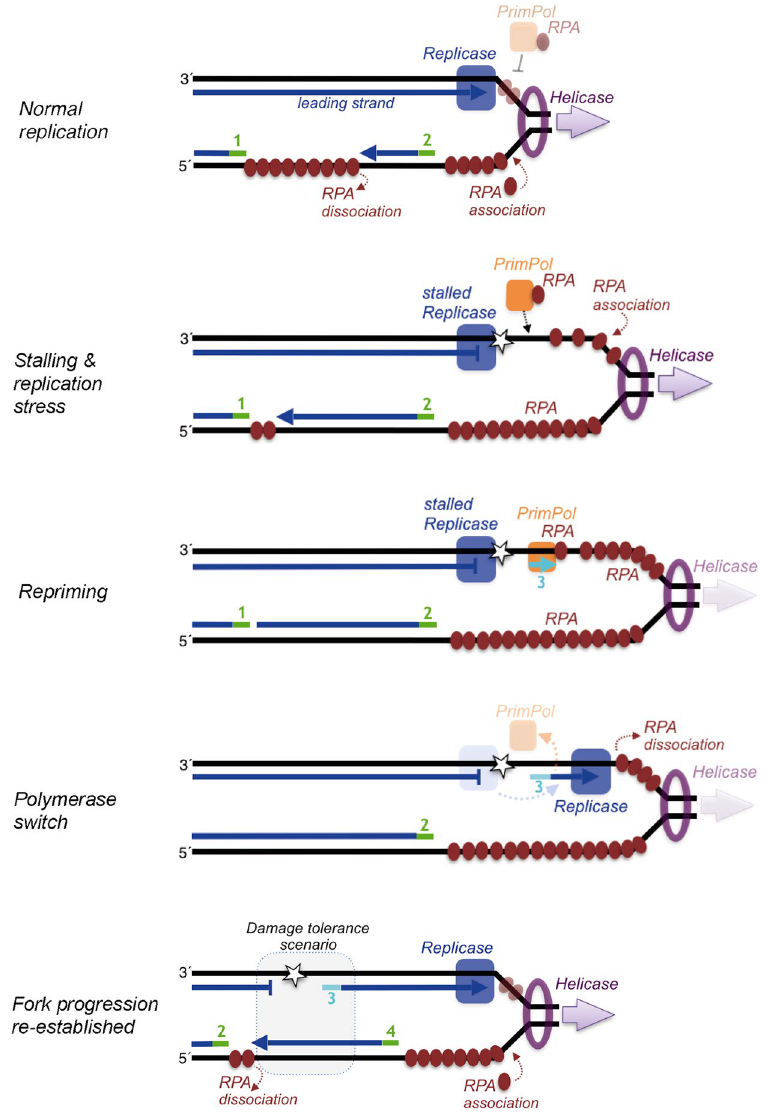
Figure 5. Model for PrimPol and RPA interactions at the replication fork during replicative stress. During normal replication fork progression, the leading replicase and the helicase are coordinated, RPA mainly binds to the lagging strand and PrimPol (depicted in association to RPA) has no access to the short ssDNA ahead of the leading replicase (likely covered by RPA). Under replicative stress, the leading strand replicase is stalled, and PrimPol/RPA now can gain access to the long stretches of ssDNA accumulated as a consequence of a sustained helicase unwinding, in a way compatible with an improved binding of RPA to ssDNA. PrimPol repriming in the leading strand triggers a polymerase switch that mobilizes the leading strand replicase from the stalling site to the new DNA primer, that becomes elongated, and the excess of RPA becoming displaced and dissociated. Recovery of the coordination between replicase and helicase re-establishes fork progression and normal lagging strand synthesis. The gap left behind in the leading strand constitutes a damage tolerance scenario, now accessible to translesion and/or repair machineries. For simplicity, the primase and polymerases acting on the lagging strand are not represented. RNA primers in the lagging strand (green) or an eventual DNA primer made by PrimPol in the leading strand (cyan) are numbered according to their proposed order of